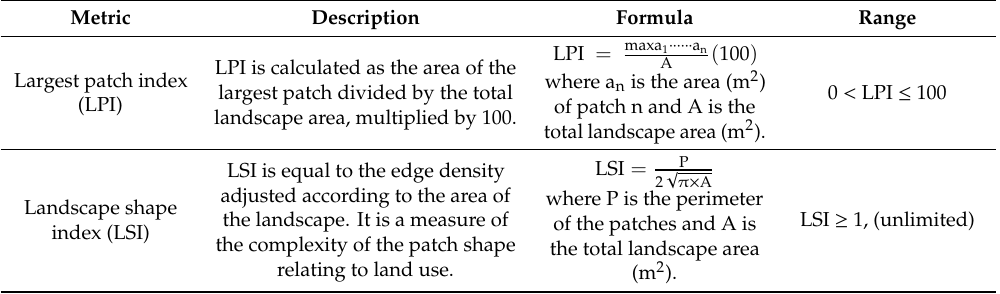
Table 2. Landscape metrics used in this